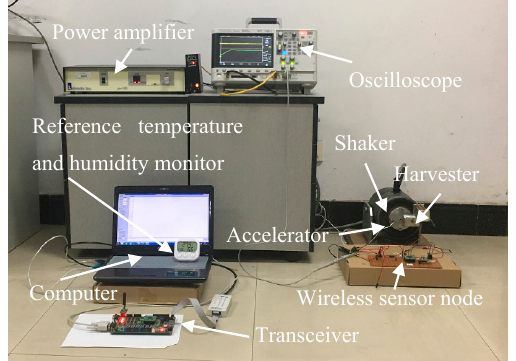
Figure 15. Photograph of the application experiments.